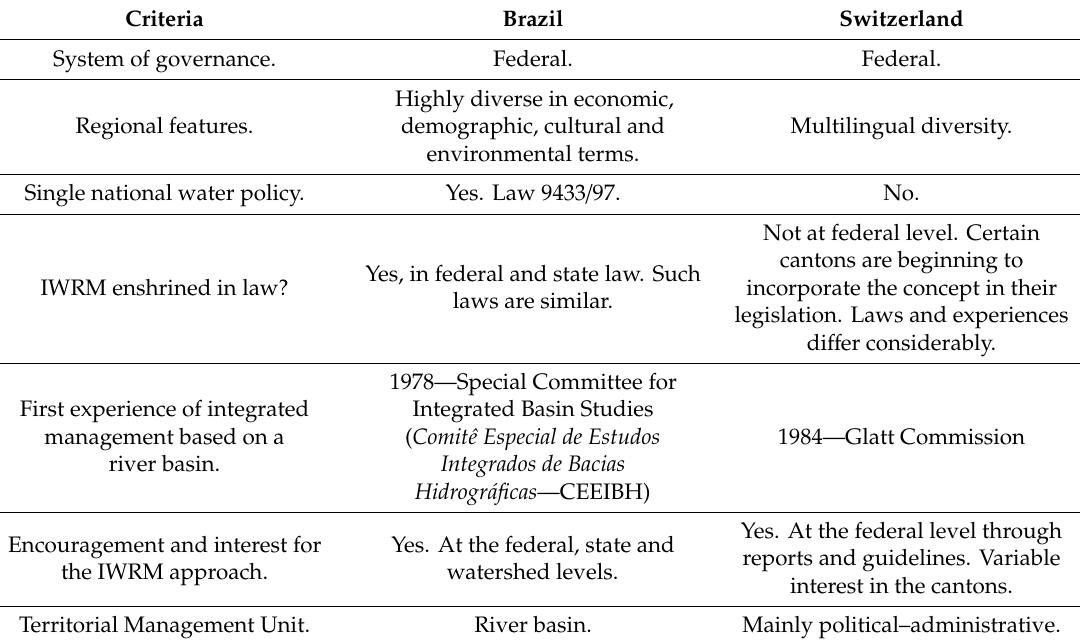
Table 1. Main characteristics of water resources management in Brazil and Switzerland. Criteria Brazil Switzerland System of